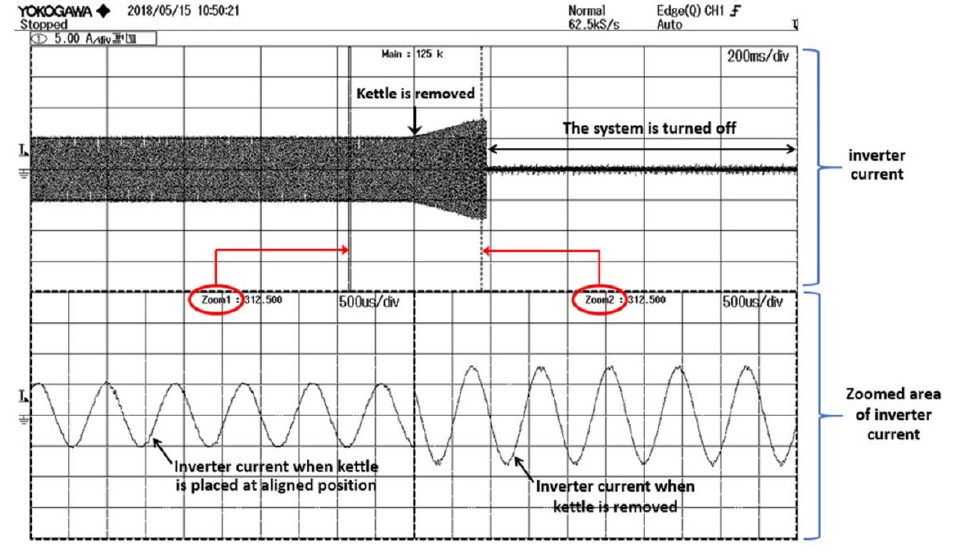
Figure 12. Experimental results of the system protection when the kettle is removed.